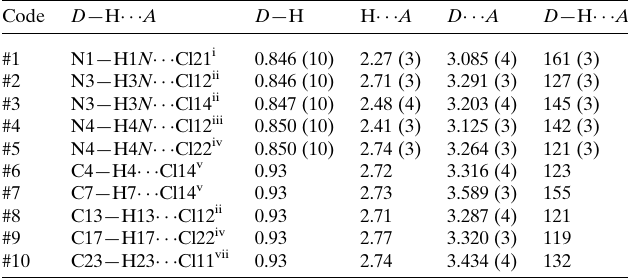
Table 3 Anion (cid:2)(cid:2)(cid:2) (cid:2) and anion (cid:2)(cid:2)(cid:2) (cid:2) + interactions (A˚ , (cid:5) ) in (I).